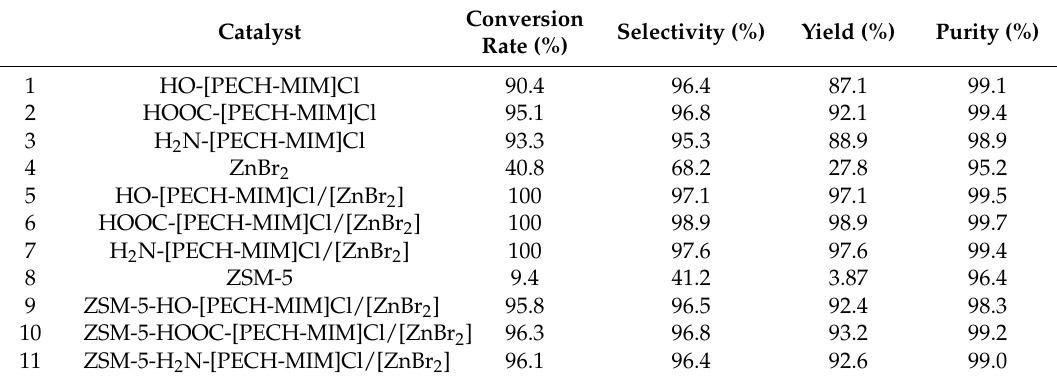
Table 1. Effects of different catalysts on catalytic performance 1